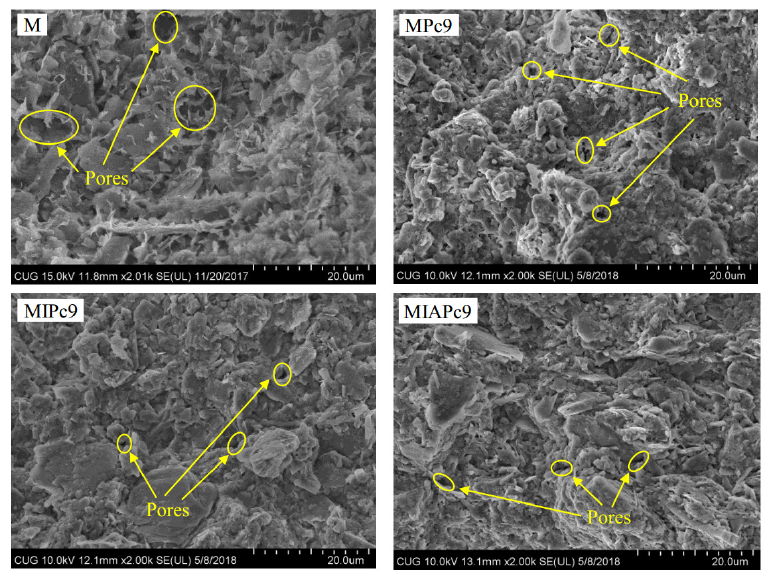
Figure 7. SEM micrographs at 2000 × for natural Ningde marine muck and different solidified samples. Quantitative analyses in pore size and structure changes were performed by using Particles (Pores) and Cracks Analysis System (PCAS) [54,55]. Figure 8 shows the pore vector images from PCAS corresponding to the SEM micrographs (2000 × ) of different samples. The physical true values converted from image processing data [56] are listed in Table 4. The small error between actual and image analytical porosity (about − 0.97% to − 5.55%) demonstrated the credibility of PCAS.